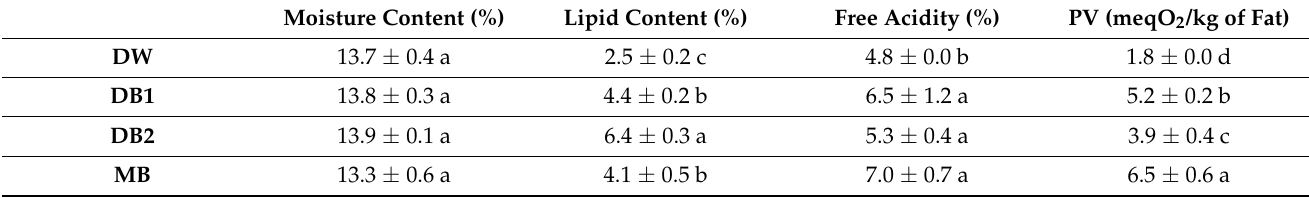
Table 1. Moisture content, lipid content, free acidity and peroxide value (PV) of the different milling